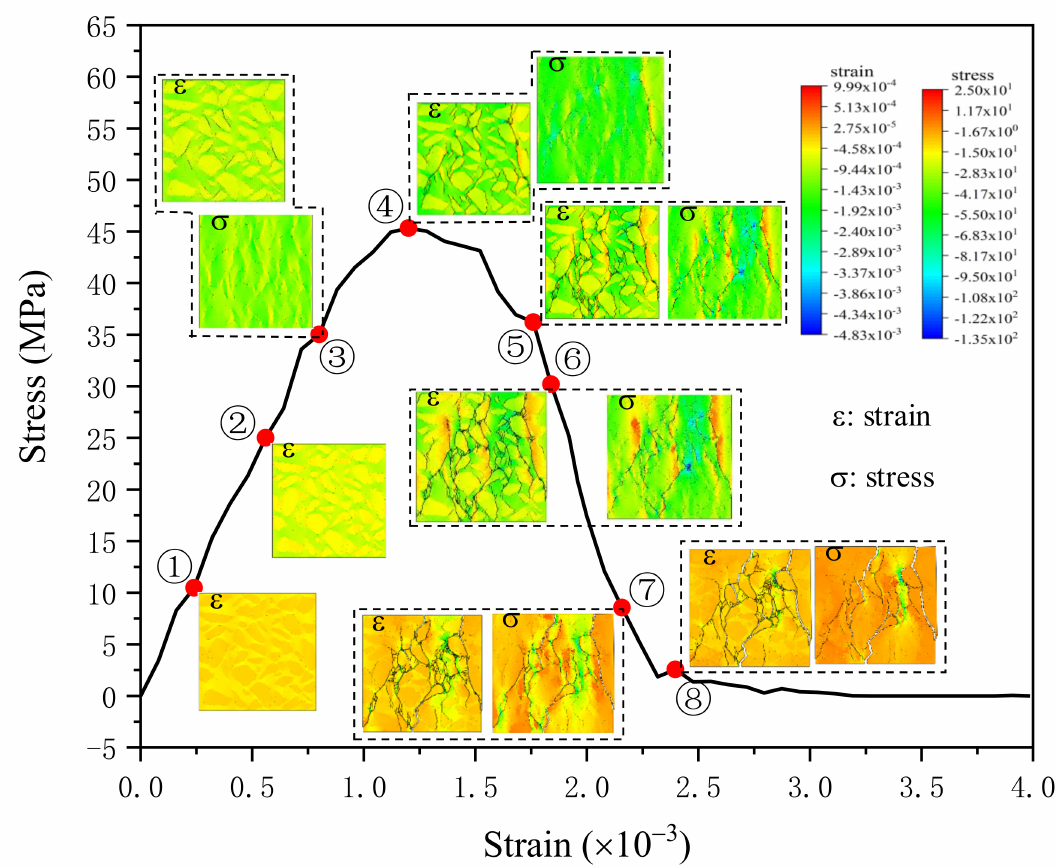
Figure 9. Strain and stress contours of NC01: (cid:192) – (cid:199) are the contours at different load stages. At the stage of 25% P max post-peak, the slope of the curve is close to zero (Figure 9 (cid:198) ). Compared with the previous point. The number of failure elements in the stress contour increases, but the distribution is almost the same; on the contrary, the number of cracks in the strain contour